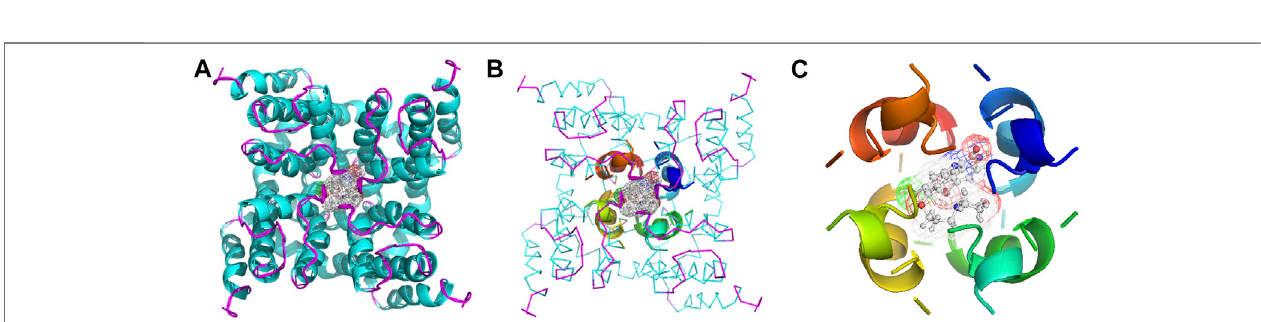
FIGURE8 | Simulated 3D complex structure of compound T16 withits target Kv1.5 channel using Sur fl exDocking. (A) Kv1.5channel wasshown according toits secondarystructure, inwhichthe α -helixes were shown incyan, and β -sheets were shown in magenta. Compound T16situated inthe center ofthe channel wasshown in mesh. (B) Binding site was shown in the rainbow cartoon. Compound T16 situated in the center of the channel was shown in mesh. Kv1.5 channel was shown in ribbon, the color of which was shown according to the secondary structure. (C) Binding site of the Kv1.5 channel was shown in the rainbow cartoon. Compound T16 in the center of the binding site was shown in the ball and stick model, which was surrounded with electronic mesh.